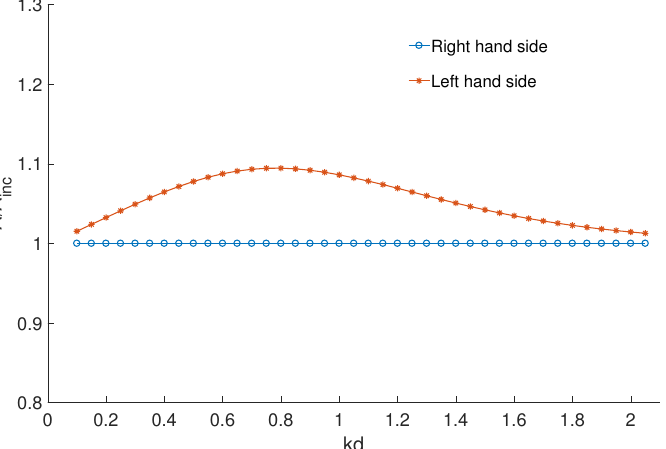
Figure 14. Incident wave amplitude A on the right hand and left hand sides over a sloping seabed with sloping angle tan θ = 1/8.